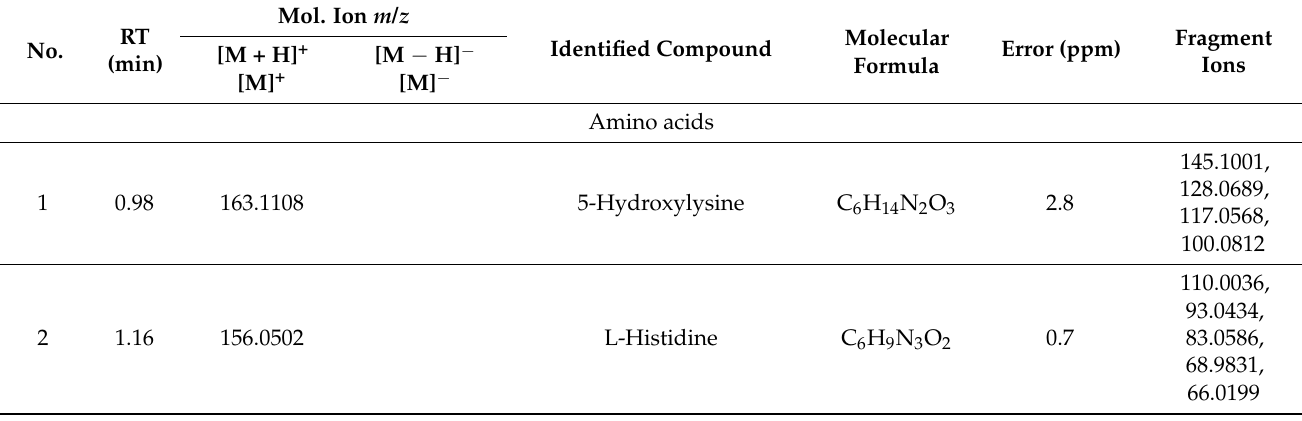
Table 1. Peak assignments of metabolites in B. armeniaca methanolic extract (BME) by Q-TOF